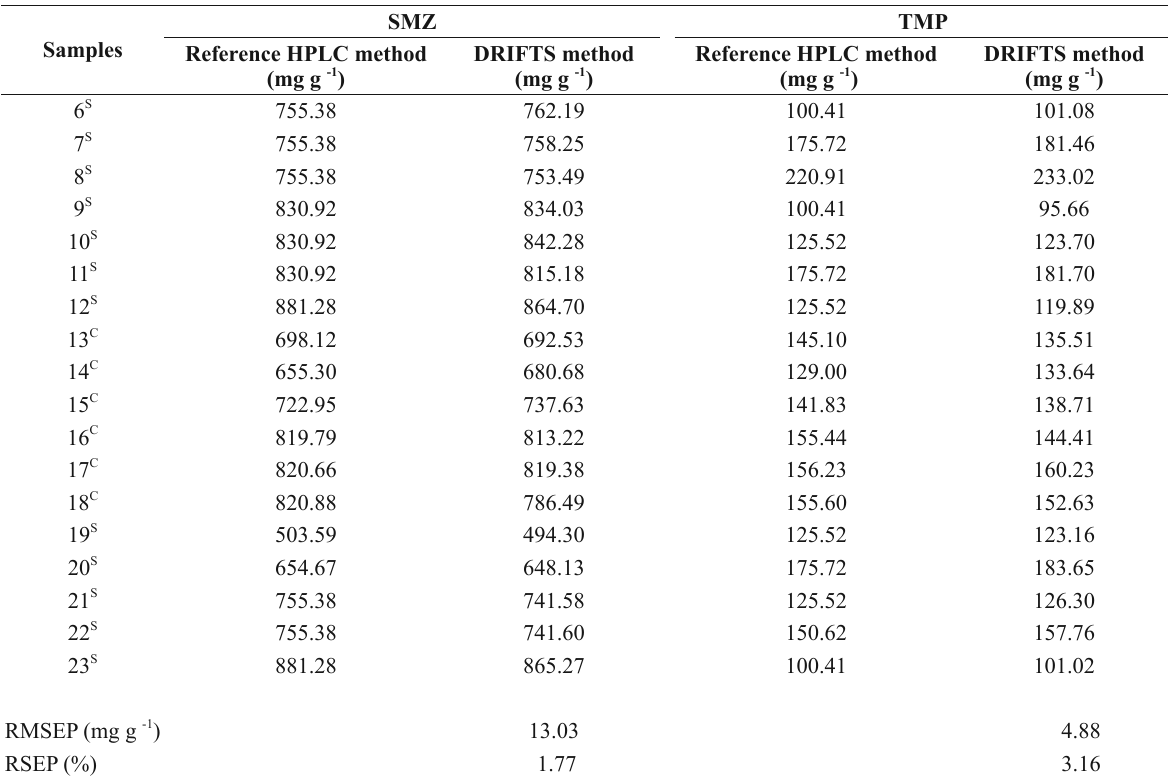
result in models with better predictive capacity.